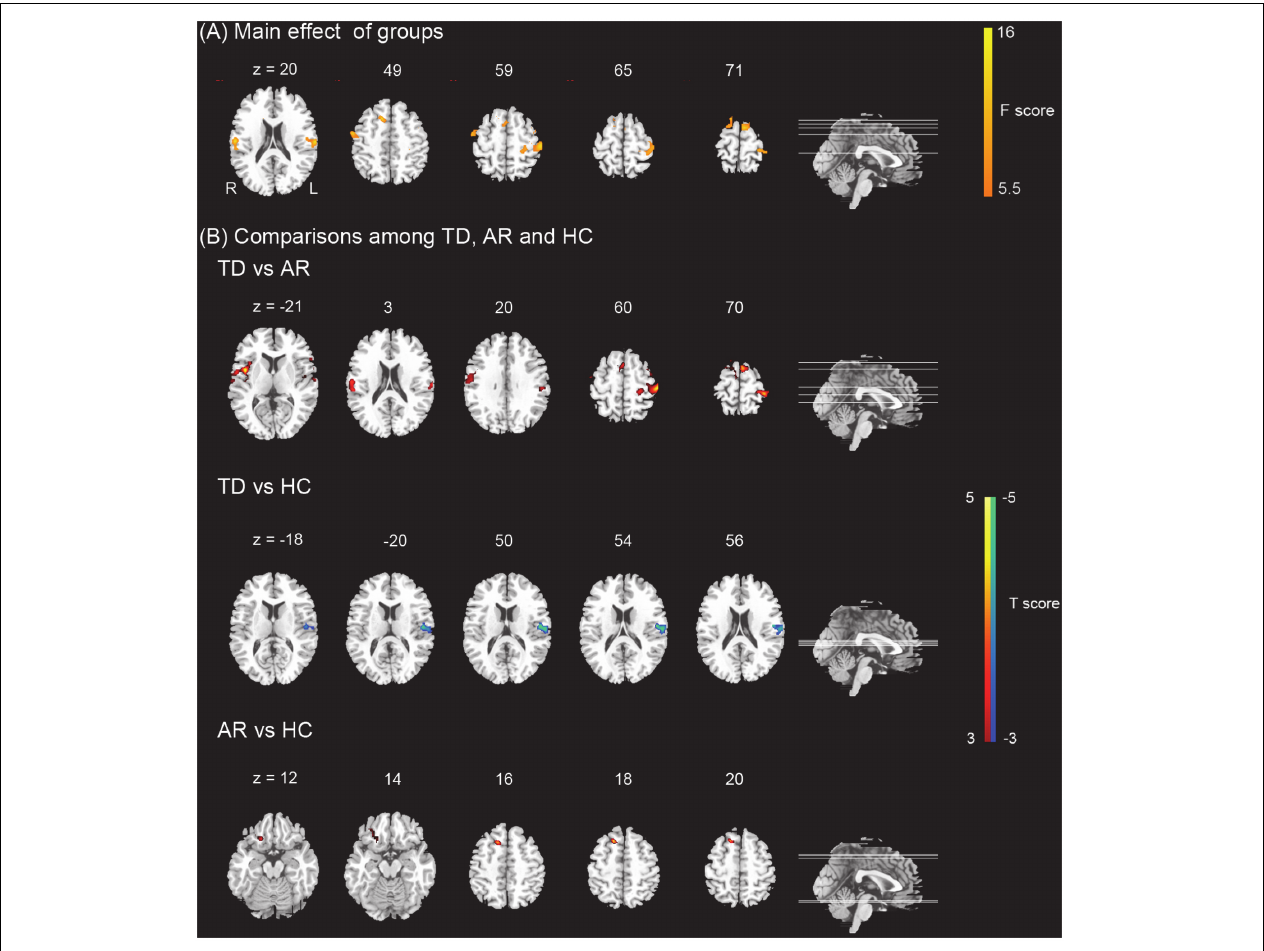
FIGURE 4 | Results of the functional connectivity (FC) of the left cerebellum. (A) Shows the main effect of group on FC [one-way ANCOVA, p < 0.005 corrected for multiple comparison at the cluster level, AlphSim corrected, F (2,69)]. Color bar represents the F -value. (B) Show the differences on FC of the left cerebellum between TD, AR, and HC ( post hoc two-sample t -test, p < 0.005 corrected for multiple comparison at the cluster level, AlphSim corrected). Color bar represents the t